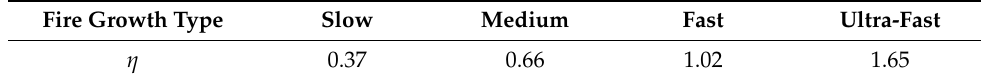
Table 5. The coefficient η with different fire growth types.